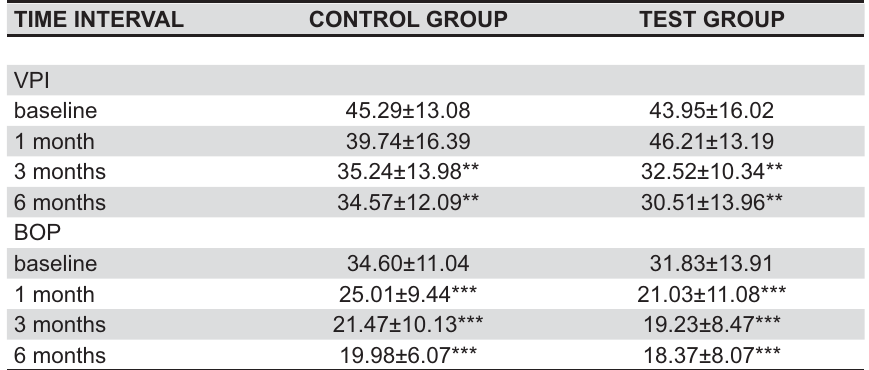
Table 2- Mean ± SD of visible plaque index (VPI) and bleeding on probing (BOP) values (%) at different time intervals for control and test (cid:31)(cid:30)(cid:16)(cid:4)(cid:3)(cid:30)(cid:27)(cid:31)(cid:4)#W(cid:10)(cid:14)